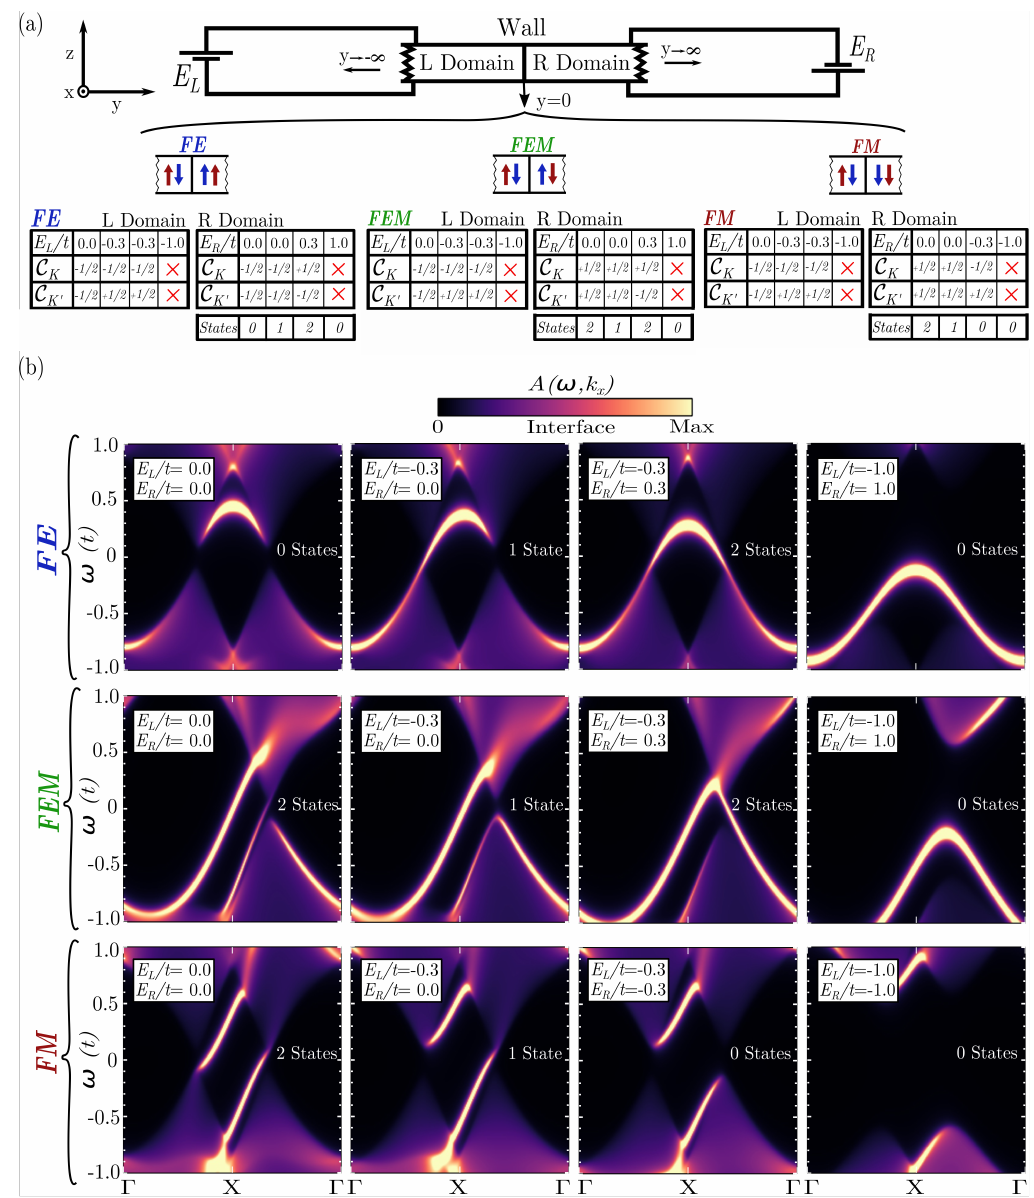
Figure 5: Magnetoelectric control of topological excitations in the domain walls of a topological multiferroic. (a) Schematic device that allows controlling the topological character of two connected ferroic domains, L (left) and R (right) domains, with ex- ternal electric fields applied in the z direction, E and E respectively. The domains L R are semi-infinite in the y direction. The domain wall occurs at y = 0. In the x di- rection the lattice is periodic. Three different ferroic domain walls can occur: F E purely ferroelectric, F M purely ferrimagnetic and F EM simultaneously ferroelectric and ferrimagnetic. The tables summarize the value of the valley Chern numbers C K and C as a function of the external electric fields for each kind of domain wall. The K (cid:48) number of emergent interface states is also included. (b) Momentum resolved inter- ) for each of the domain walls F E (top panels), F EM face spectral function A ( ω , k x (middle panels) and F M (bottom panels) and for the different E and E values sum- L R marized in the tables of panel (a). The calculations were performed with the effective / t | = 2.0 and λ / t = Hamiltonian (eq.(6)) considering | m / t | = 0.6, | ∆ Z R